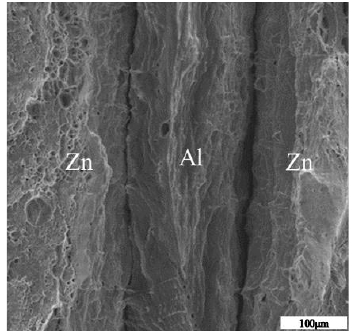
Figure 14. Macroscale images of the fractures.